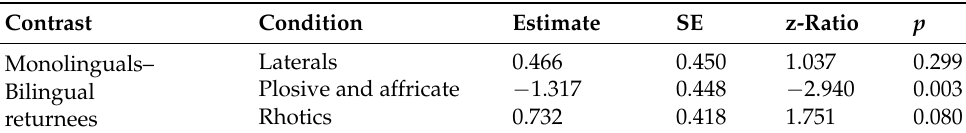
Table 5. Pairwise comparisons of accuracy rates between monolinguals and bilingual returnees for each condition. ‘Estimate’ shows the difference in estimated marginal means on the log odds ratio scale. Results are averaged over the levels of dialect.